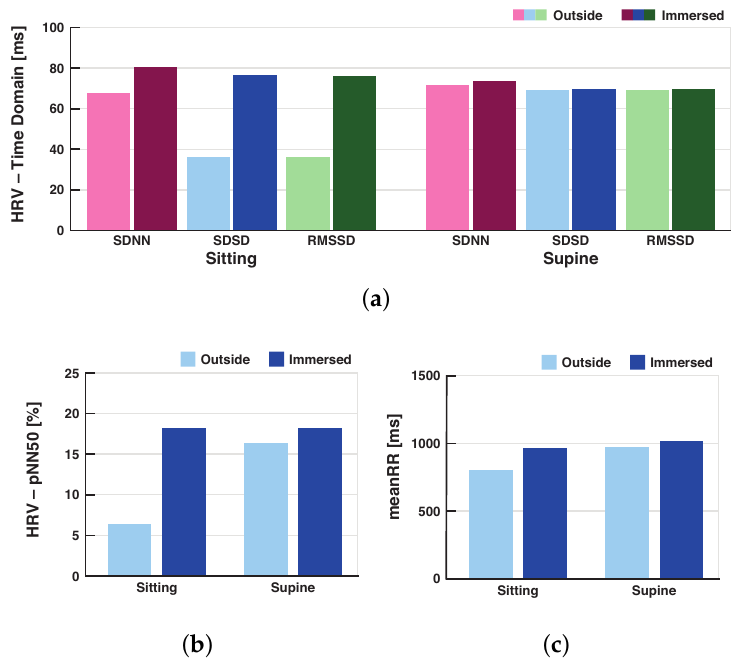
Figure 8. Time domain HRV parameters as a mean over all subjects. Standard deviation of NN intervals (SDNN), standard deviation of successive differences (SDSD) and the root mean square of successive differences (RMSSD) are visualized in ( a ), on the left side for the sitting and on the right side for the supine position. Bright colors are outside the water and dark colors from the immersed condition. In ( b ) the changes in the percentage of the number of adjacent RR intervals which differ more than 50 ms (pNN50) is given and in ( c ) the differences of the arithmetic mean value of all RR intervals. Table 1. Time domain HRV parameters as a mean over all subjects. Sitting Sitting Supine Parameter Outside Water Inside Water Outside Water